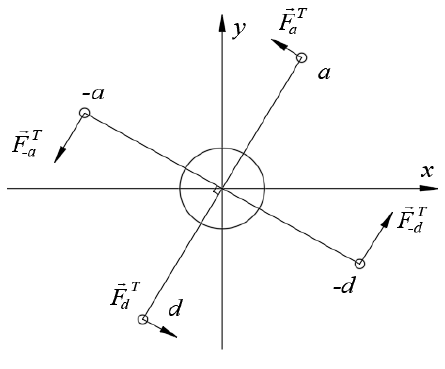
Figure 8. Motor torque.